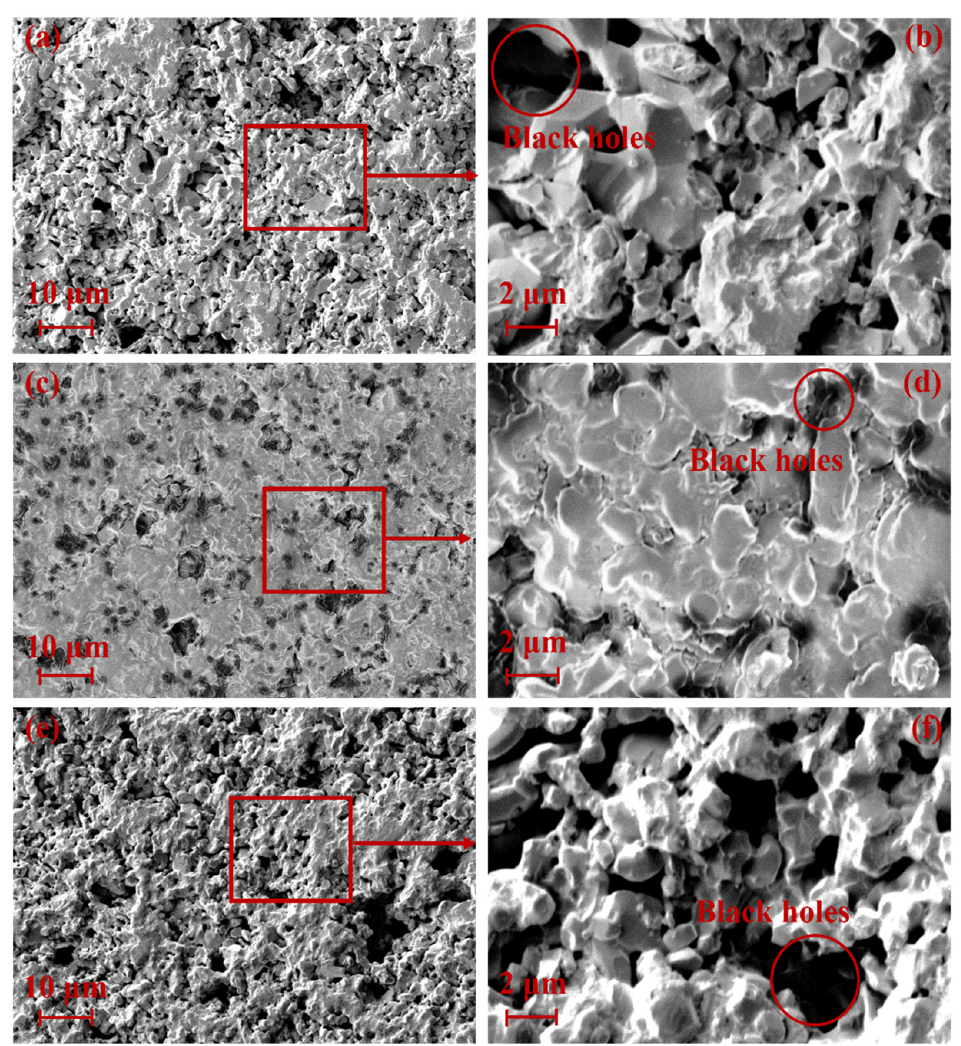
Figure 7. SEM images of the St-x type ceramics: ( a , b ) St1, ( c , d ) St2, ( e , f ) St3.